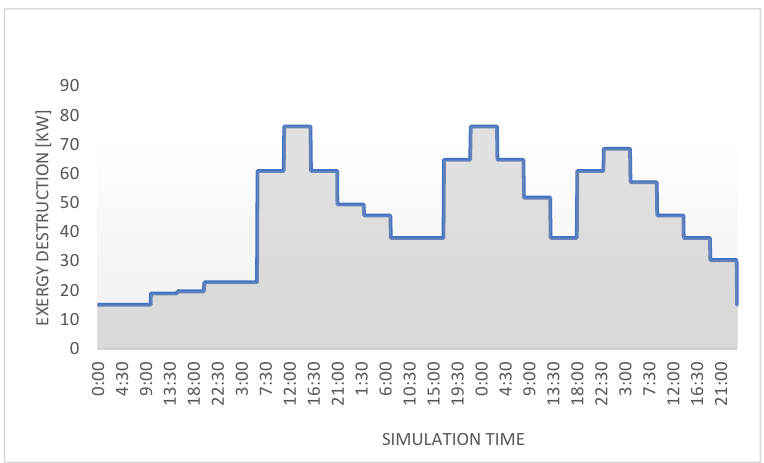
Figure 15. The rate of exergy destruction during simulation time.